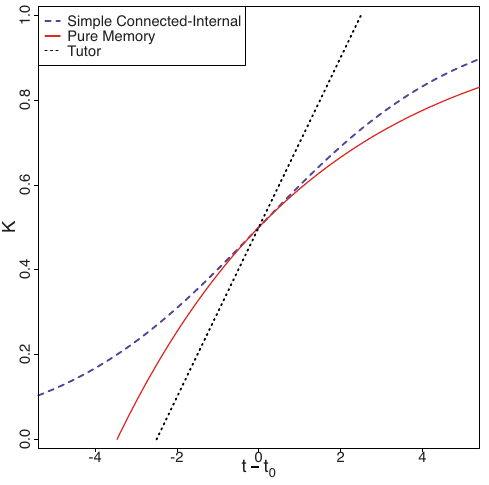
FIG. 1. (cid:1) Color (cid:2) Predictions of knowledge K (cid:1) t (cid:2) from our three “pure” models. We have assumed that k a = (cid:1) memory = (cid:1) connected / 2, which matches the learning rates of simple connected and pure memory models at t =0 (cid:1) where K T 0 =0.5 (cid:2) . The learning rate is pro- portional to the slope. Thus, the tutoring model educates fastest everywhere, even for t (cid:6) 0 (cid:1) i.e., before the pretest (cid:2) . The simple connected-external model (cid:1) not shown (cid:2) has the same time depen- dence as the pure memory model (cid:1) although it differently scales depending on K external (cid:2)